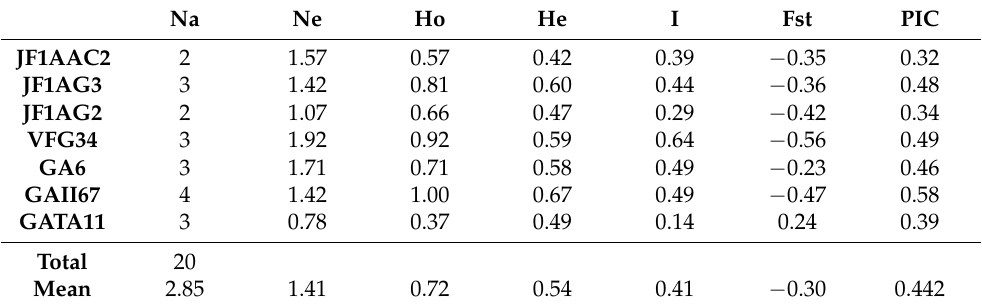
Table 2. Data summary for 7 microsatellite markers across the 14 Algerian faba bean accessions. Na Ne Ho He I Fst PIC JF1AAC2 2 1.57 0.57 0.42 0.39 − 0.35 0.32 JF1AG3 3 1.42 0.81 0.60 0.44 − 0.36 0.48 JF1AG2 2 1.07 0.66 0.47 0.29 − 0.42 0.34 VFG34 3 1.92 0.92 0.59 0.64 − 0.56 0.49 GA6 3 1.71 0.71 0.58 0.49 − 0.23 0.46 GAII67 4 1.42 1.00 0.67 0.49 − 0.47 0.58 GATA11 3 0.78 0.37 0.49 0.14 0.24 0.39 Total 20 Mean 2.85 1.41 0.72 0.54 0.41 − 0.30 0.442 Na, number of alleles; Ne, number of effective alleles; observed (Ho) and expected heterozygosity (He); I, Shannon’s information index; Fst, genetic differentiation; PIC, polymorphic information content. The seven loci generated a total of 20 alleles with a mean of 2.85 alleles per lo- cus. For each locus, allele numbers varied from 2 (JF1AAC2, JF1AG2) to 4 (GAII67). The polymorphism information content (PIC) for the seven SSR primers extended from 0.32 (JF1AAC2) to 0.58 (GAII67) with a mean of 0.44. Observed heterozygosity (Ho) was between 0.57 (JF1AAC2) and 1.00 (GAII67) with an average of 0.72, while the